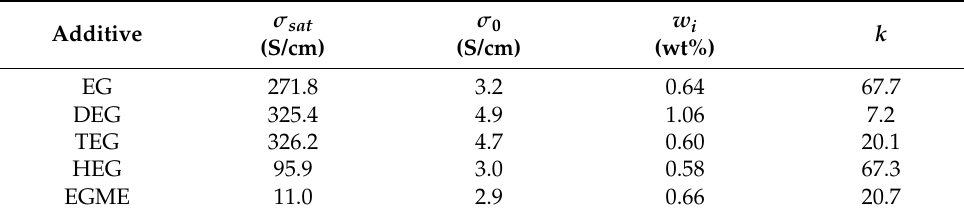
Table 2. Fitting parameters of a sigmoidal logistic function (Equation